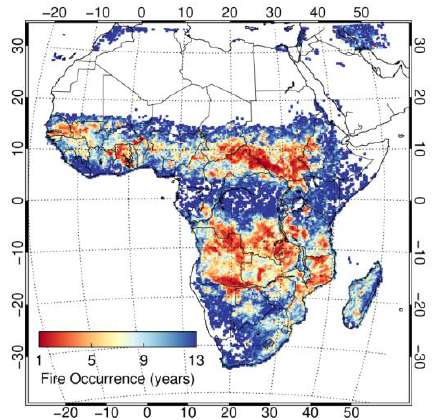
Figure 9. MCD64A1 burned area derived fire occurrence (2004–2016) at 0.25° resolution using MCD64 A1 burned area product between 2004 and 2016.